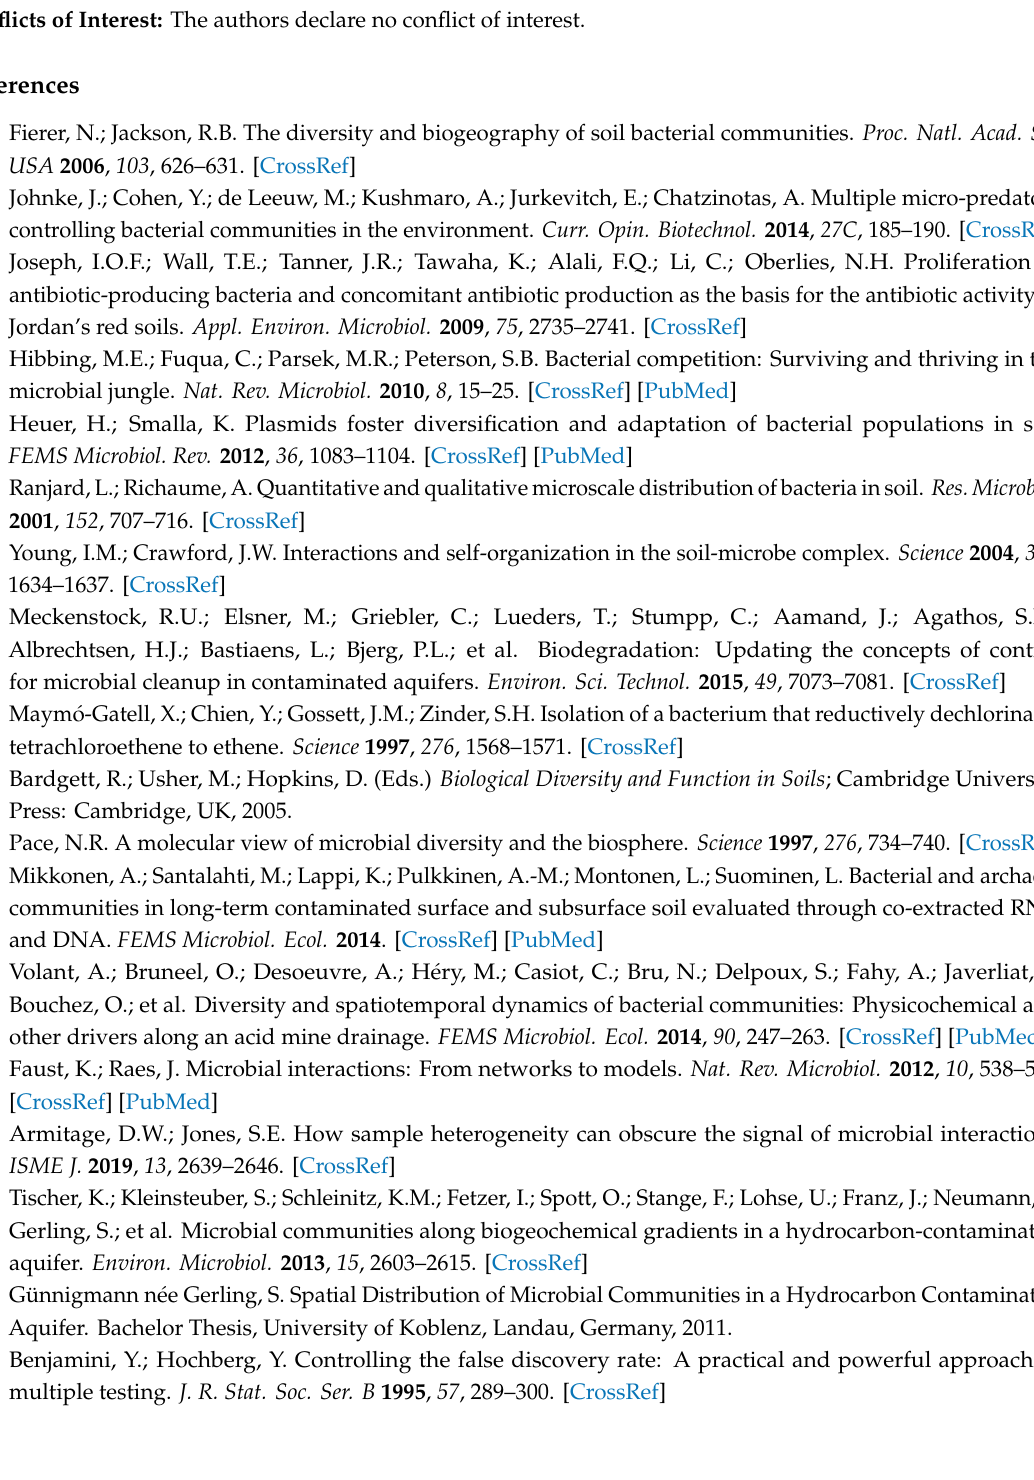
Figure S7: fragment occupancy distribution, Tables S1 and S2: characterization of network modules for Rsa I and Hae III